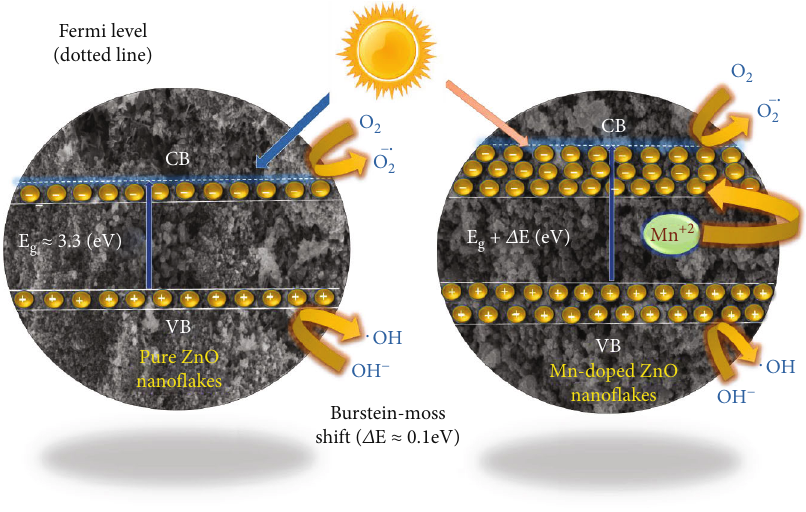
Figure 9: Schematic representation of the Burstein-Moss e ff ect in Mn-doped ZnO nanoparticles. Table 2: Comparison of photocatalytic performance of synthesized photocatalysts with literature. Light source